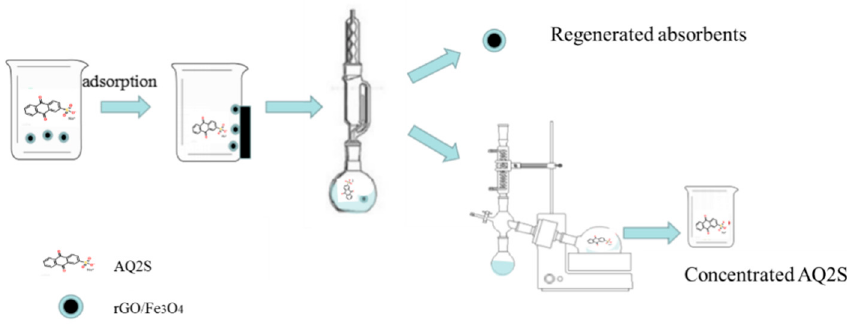
Figure 1. Flow chat of the AQ2S adsorption/recovery process with rGO/Fe 3 O 4 .